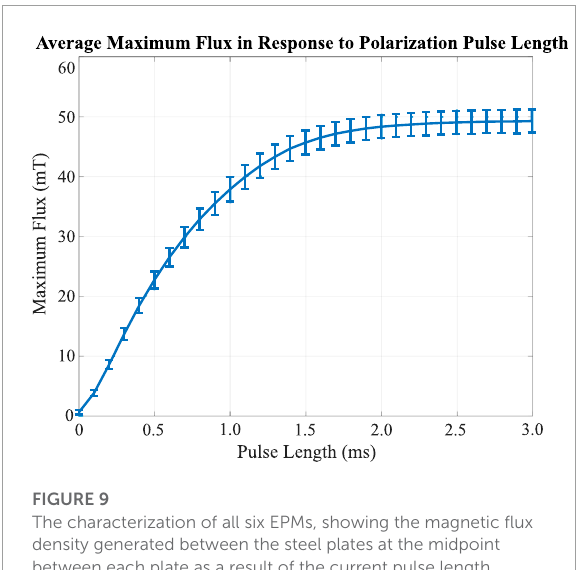
FIGURE 9 The characterization of all six EPMs, showing the magnetic flux density generated between the steel plates at the midpoint between each plate as a result of the current pulse length applied to each EPM. Data was collected with a teslameter, as described in Section 2.1 .